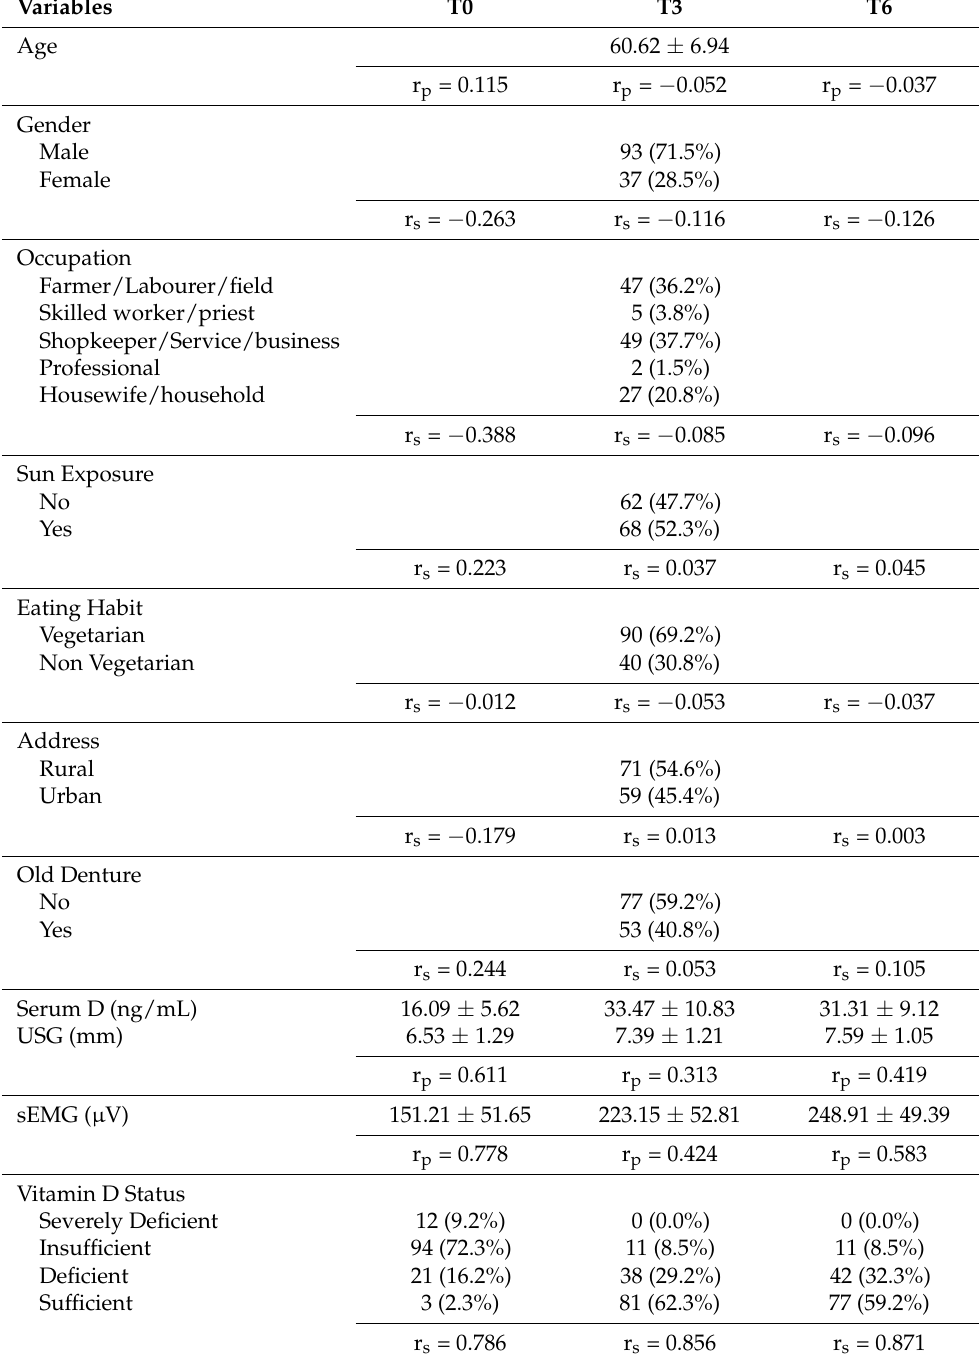
Table 1. Descriptive Characteristics and Correlation with each time of recording of Vitamin